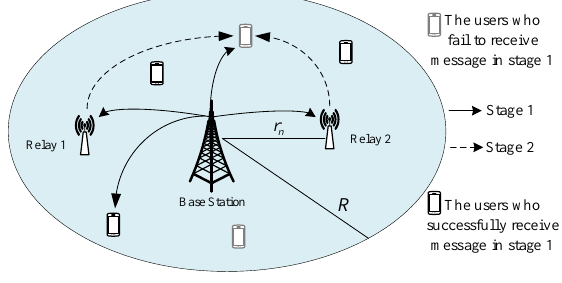
Figure 1. Network model.